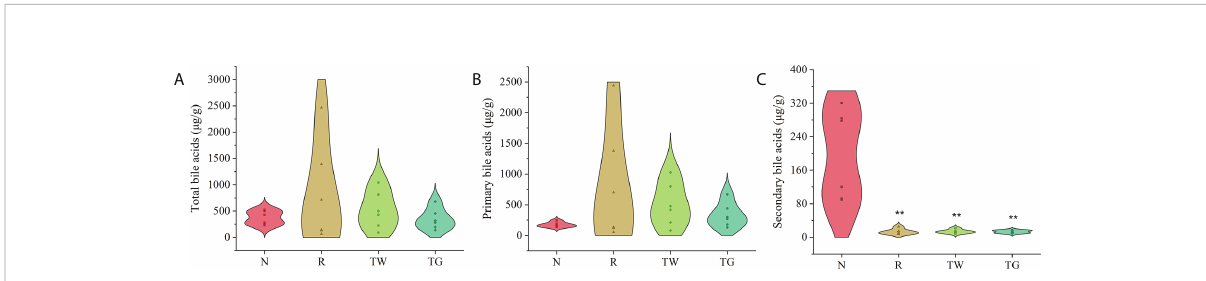
FIGURE 5 Effects of QWBZP-TG on the bile acid (BA) contents in AAD mice. (A) Total BAs, (B) Primary BAs, and (C) Secondary BAs. N, normal control group; R, antibiotic-associated diarrhea (AAD) restore group; TW, Qiwei Baizhu Powder (QWBZP) decoction group; TG, total glycosides of Qiwei Baizhu Powder (QWBZP-TG) group. ** P < 0.01 compared with the N